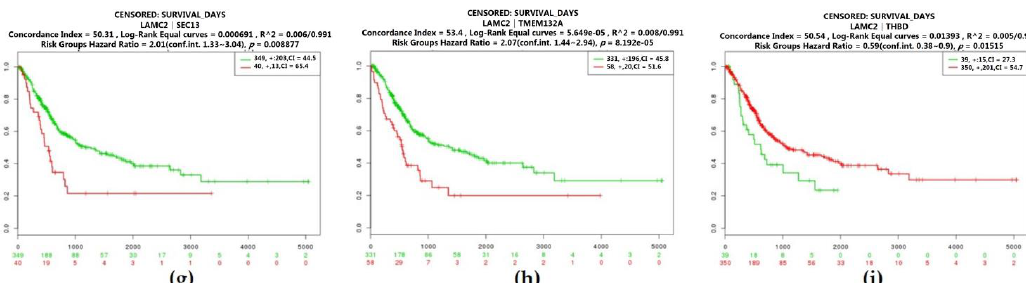
Figure 7. Overall survival of the co-expression of hub genes of bladder cancer with grade 2 carcinoma based on Kaplan–Meier plotter. The horizontal axis represents the time to event. The patients were stratified into the high-level group and low-level group and labeled with color. The red line indicates the samples with high risk, and the green line shows the samples with low risk. p < 0.05 is considered a statistically significant difference in mortality between the high-level group and low-level group. ( a ) Laminin subunit gamma 2 (LAMC2); ( b ) Tenascin C (TNC); (c) SET domain containing 5 (SETD5); ( d ) Co-expression of LAMC2 and TNIP1; ( e ) Co-expression of LAMC2 and PTTG1IP; ( f ) Co-expression of LAMC2 and LAMA3; ( g ) Co-expression of LAMC2 and SEC3; ( h ) Co-expression of LAMC2 and TMEM132A; ( i ) Co-expression of LAMC2 and THBD. Abbreviation: TNIP1 TNFAIP3 Interacting Protein 1 , PTTG1IP Prostaglandin-endoperoxide synthase 1 , LAMA3 Laminin subunit alpha-3 , SEC3 Exocyst complex component 1 , TMEM132A Transmembrane protein 132A , THBD Thrombomodulin .